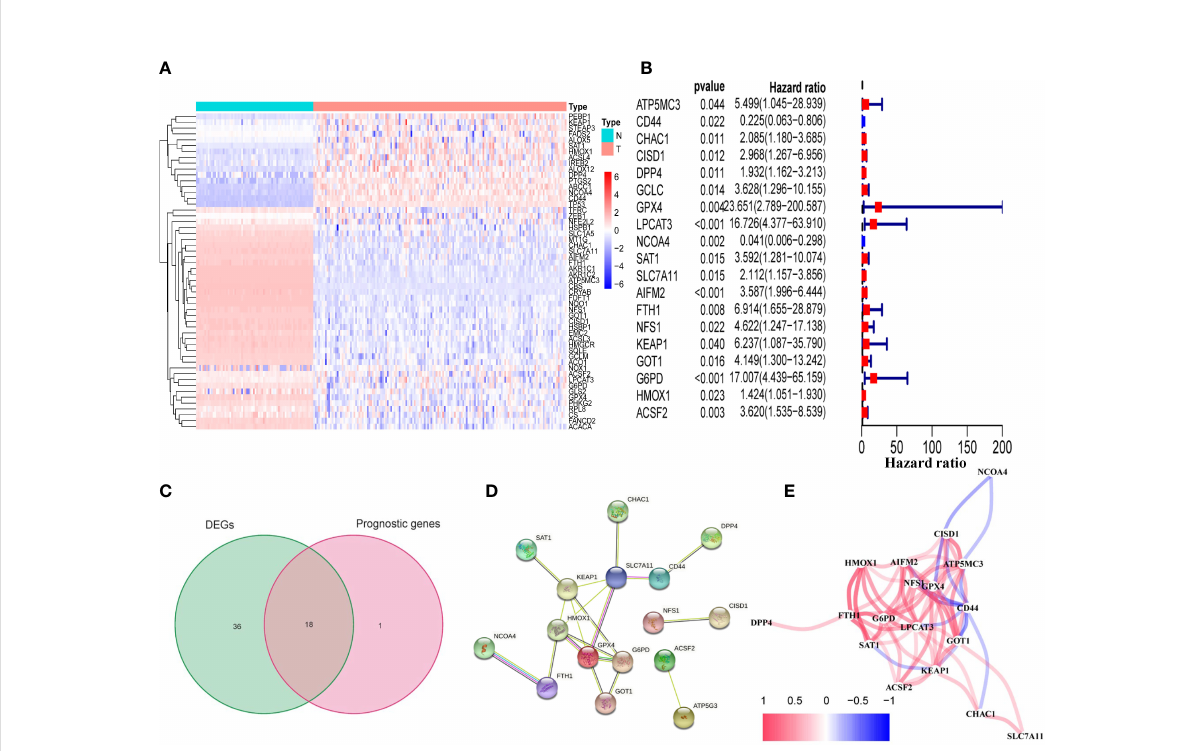
FIGURE 2 Identi fi cation of prognostic FRDEGs in the TCGA cohort. (A) Heat map of the 54 DEGs (T: tumor sample; N: normal sample). (B) Forest plots showed the results of the univariate cox regression analysis between gene expression and OS (p < 0.05). (C) Venn diagram identi fi ed FRDEGs. (D) The PPI network revealed the hub genes. (E) The correlation network among the 18 DEFRGs genes. Different colors represent the correlation coef fi